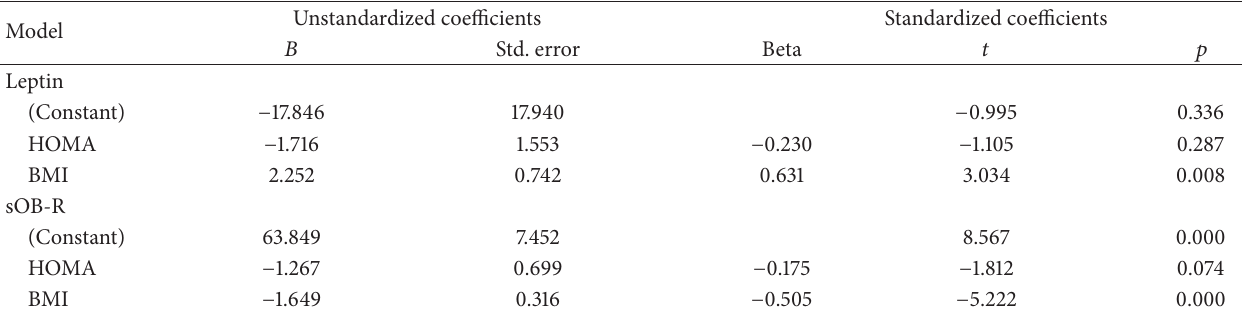
Table 3: The correlation between serum leptin, sOB-R, and both BMI and HOMA-IR in PCOS subjects.